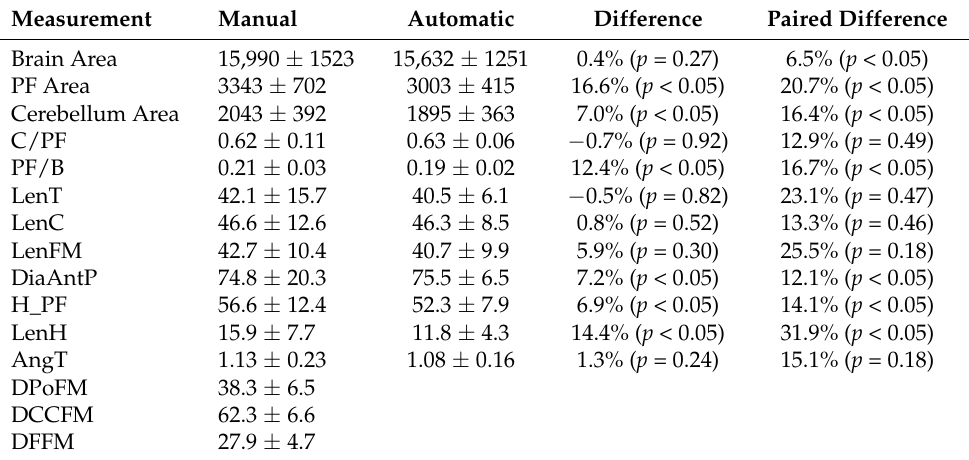
Table 1. Morphological measurements obtained manually or automatically (mean ± std) and per- centage difference of medians (either not paired or paired, with significance inspected respectively with Wilcoxon rank sum and signed rank tests). Areas are measured in pixels covered by the region, lengths in pixels and the angle in radiants. The number of processed MRIs is